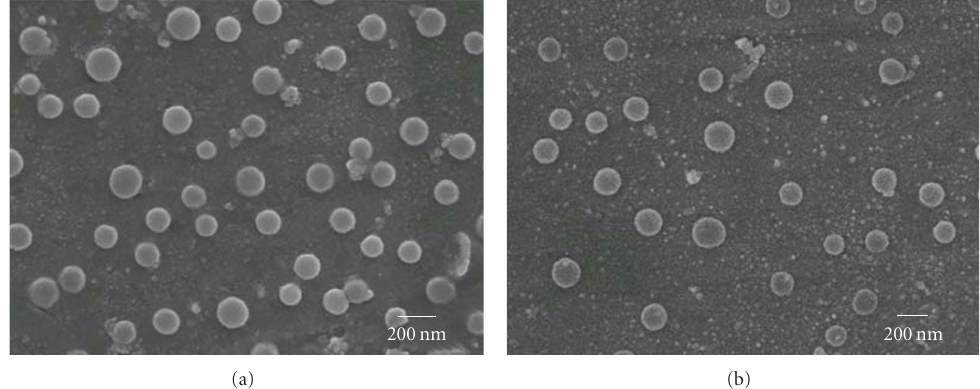
Figure 1: SEM images of magnetic nanoparticles and nanoparticle/DNA complexes: (a) SEM image of magnetic nanoparticles. The SEM image shows the spherical shape of the magnetic nanoparticles with diameter about 150 nm. (b) SEM image of nanoparticle/DNA complexes. The nanoparticle/DNA complexes are also spherical but with rougher surface. The diameter of the complexes is about 200 nm.